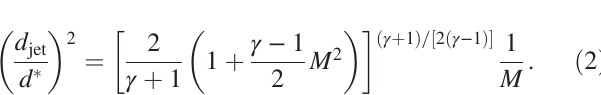
TABLE I. An overview of the designed and manufactured nozzles. The following parameters are mentioned: the software used to =d (cid:2) , the pressure ratio between the gas cell and calculate the inner contours, the ratio between the nozzle exit and throat diameters d exit the gas cell chamber P 0 =P , the remaining density fluctuations Ξ and their periodicity Λ , the Mach number M , the manufacturing bg technique, and the surface roughness of the nozzle inner contour R a . d (cid:2) ¼ 1 mm, P 0 ¼ 300 mbar, and T 0 ¼ 300 K for all cases. Nozzles